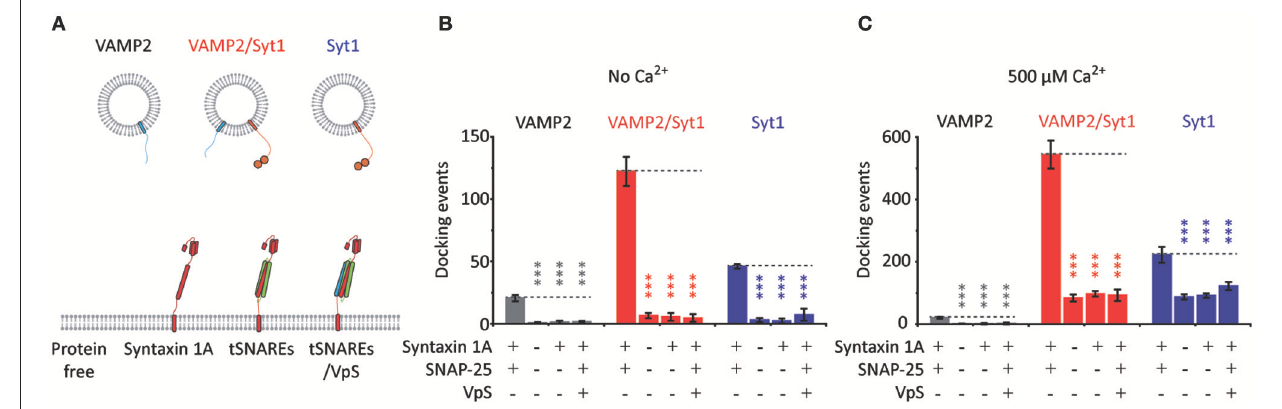
FIGURE 4 | Vesicle docking requires both t-SNAREs, syntaxin 1A and SNAP-25. (A) Schematics for the single vesicle-to-SBL docking assay. We prepared v-vesicles reconstituted with VAMP2, both VAMP2 and Syt1, and only Syt1. We separately evaluated docking of v-vesicles onto SBLs reconstituted without proteins, with only syntaxin 1A, with t-SNAREs, and with t-SNAREs disabled by VpS. (B) The number of docking events for v-vesicles reconstituted with VAMP2 only (gray), with VAMP2 and Syt1 (red), and with Syt1 only (blue) in the absence of Ca 2 + . (C) The number of docking events for v-vesicles reconstituted with VAMP2 only (gray), with VAMP2 and Syt1 (red), and with Syt1 only (blue) in the presence of 500 µ M Ca 2 + . For (B) and (C) the data are shown as means ± SD . Statistical significance was assessed by Student’s t -test (*** p < 0.005; NS, no significant difference; n = 3 independent